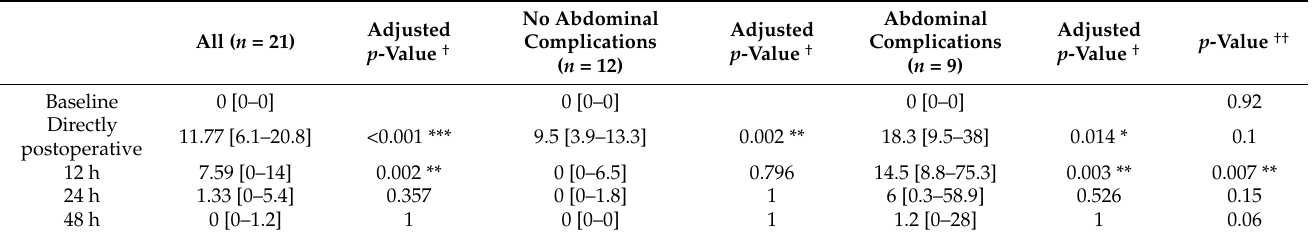
Table 3. Heat-shock protein 70 serum levels (ng/mL) reported as median [interquartile range]. † Ad- justed p -values after Friedman analysis with Bonferroni correction for comparison to baseline